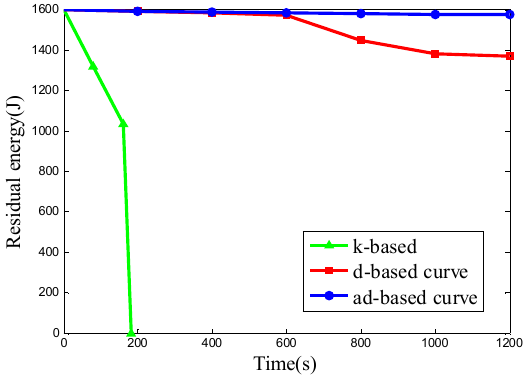
Figure 15. The residual energy of the network in node deployment (a): C 1 , C 2 , C 4 are deployed with 50 nodes and C 3 is deployed with 650 nodes.